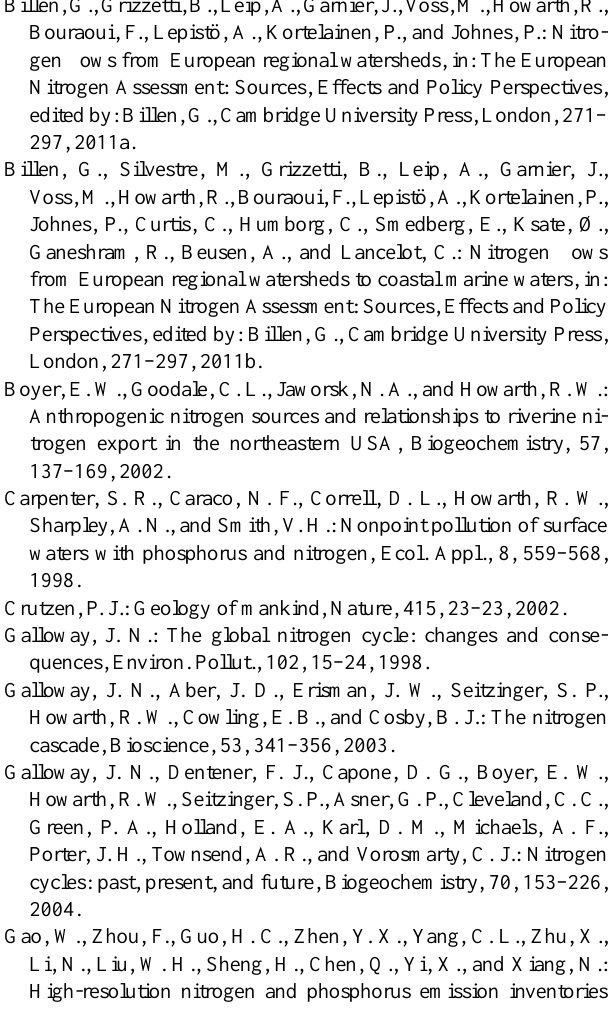
Figure 7. Main sewage treatment plants in the basin and their cover scope. In the study period, there are a total of six major plants to treat sewage in the basin, and all of them are located in the urban area. In spite of small overlaps between wastewater pipe networks discharged to different plants, sewage transportations are mostly confined in one